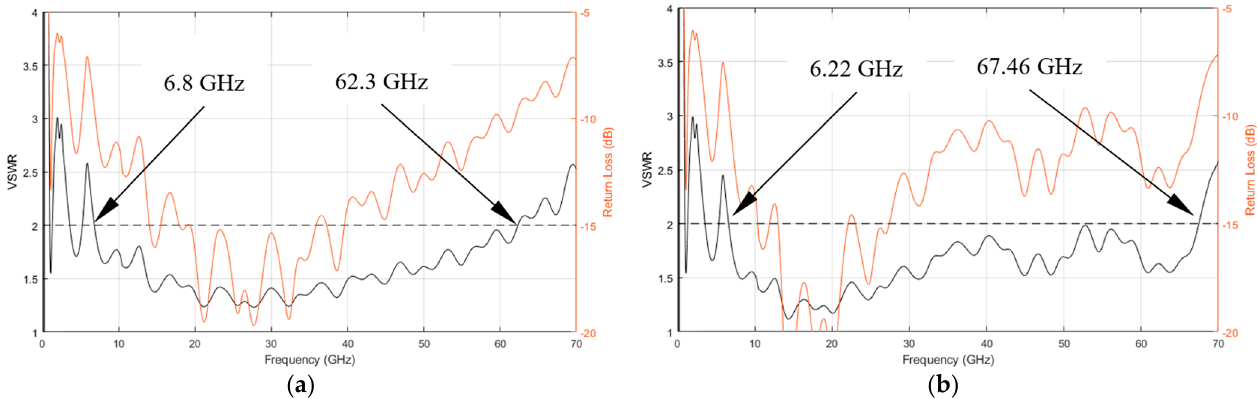
Figure 9. The input characteristics of the radiation structures ( a ) the base MBA without dielectric ring and cover, and ( b ) the base MBA just with the inner dielectric ring.